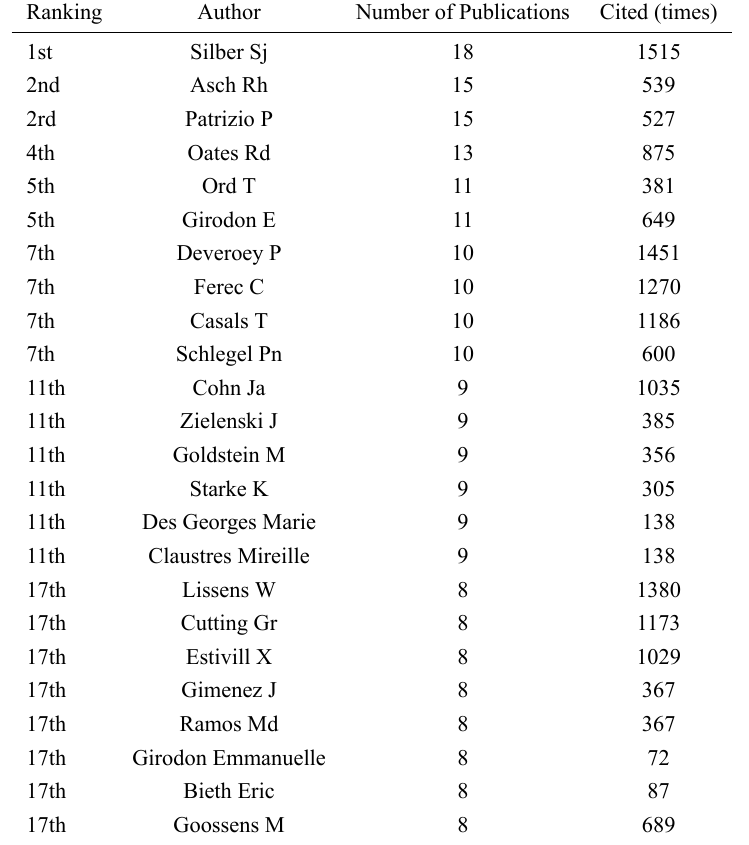
Table 3. The most productive authors on the research of absence of vas deferens (Top